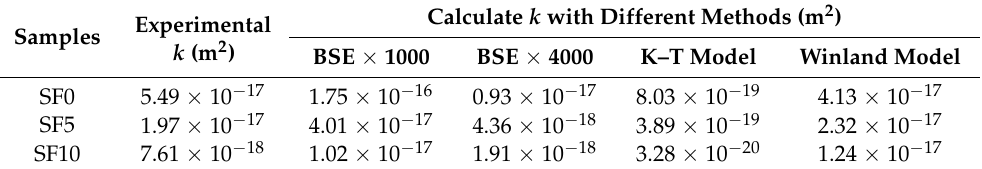
Table 3. Gas permeability of mortar samples obtained from different